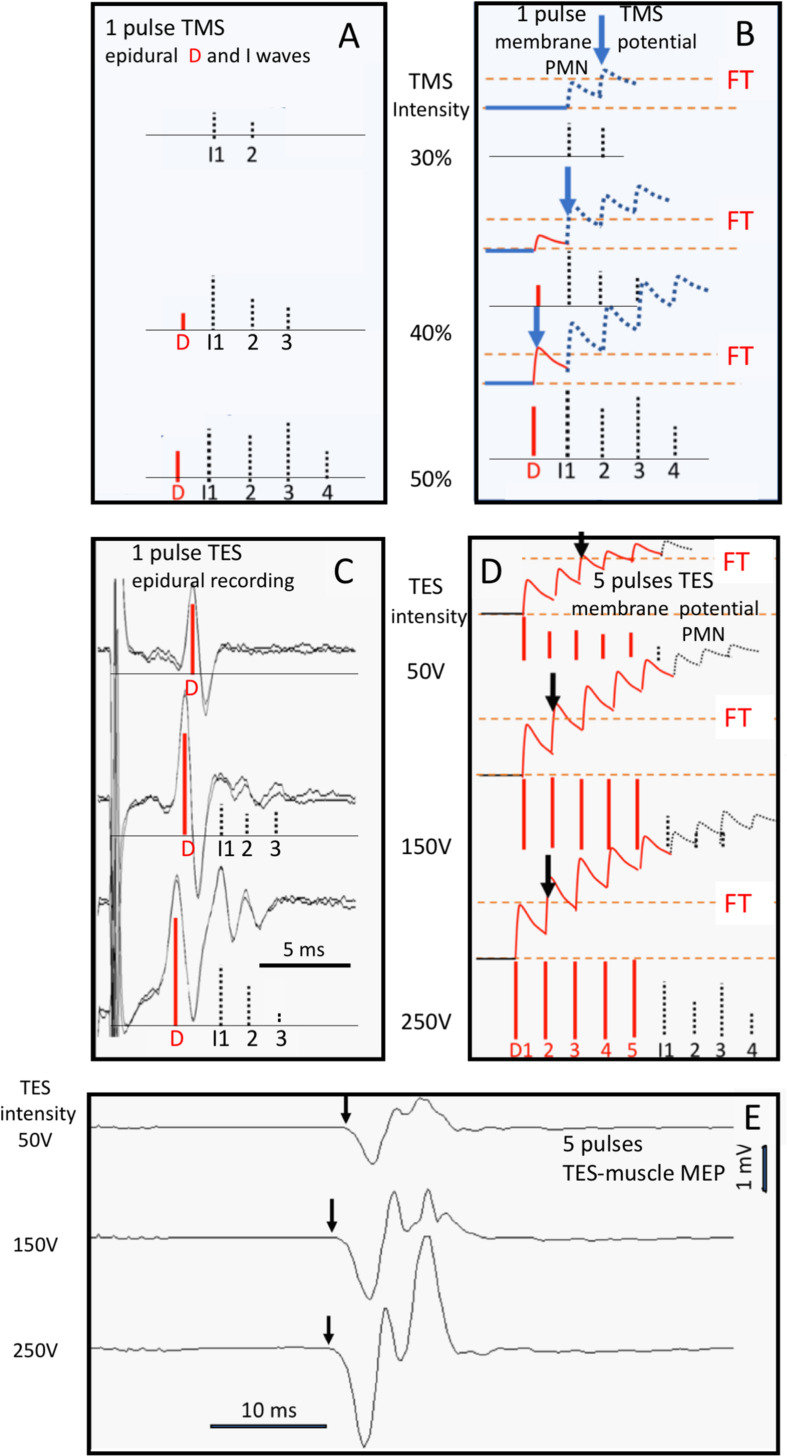
Human data visualizing the relation between D- and I-waves of TMS (A,B) and TES (C–E) mMEPs and the shortening effects on MLTs at three stimulation intensities: respectively, 30, 40, and 50% for TMS and 50, 150, and 250 V for TES. The vertical arrows in E point at the MLTs of the mMEPs. D-waves are indicated by red vertical bars and I-waves by gray bars. (A) Bars for which the height represents the size of epidural D- and I-waves from single-pulse TMS are reconstructed from the epidural recordings of Kaneko et al. (1996)
(C) intra-operative epidural MEP at single-pulse TES and (E) mMEP response at five pulses per train; ipi = 1.3 ms. (B,D) are artist impressions of the course of EPSP summations of the MN membrane potentials depicted in graphs (A,C). (C–E) Belong to a clinical patient (Department of Neurosurgery, UMCG, University of Groningen, Netherlands) under propofol/sufentanil anesthesia during intra-operative monitoring with (C) single-pulse TES epidural descending volleys and (E) multipulse TES mMEP recordings with five pulses per train of the same patient; ipi = 1.3 ms. The vertical arrows in panels (B,D) indicate the first crossings of the imaginary EPSP stair function (the abortion of the stair function by a transition into a firing action potential is not visualized for didactic reasons) at the FT.